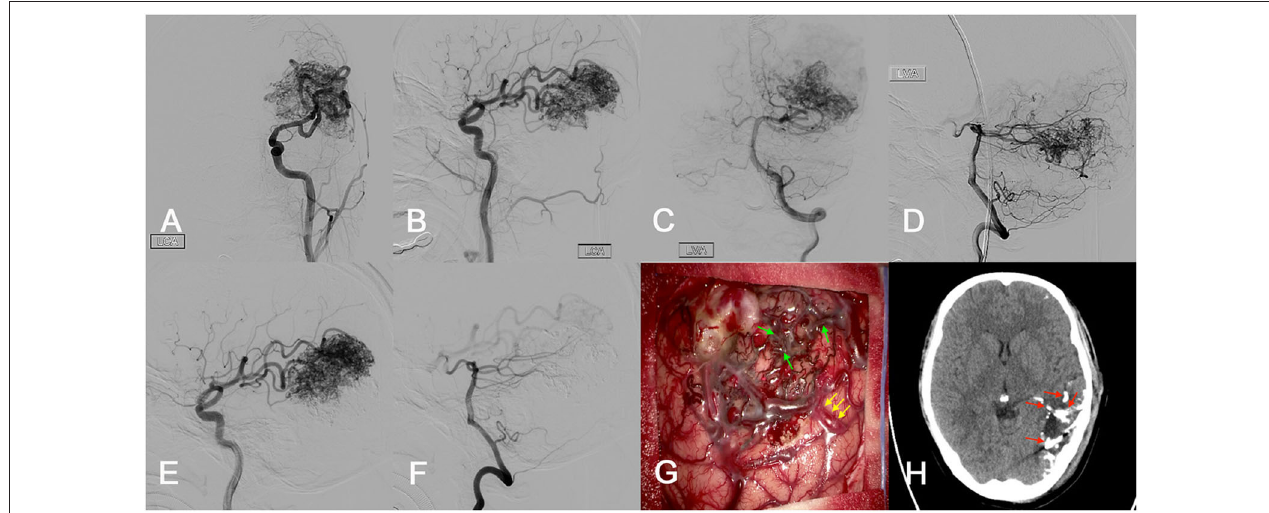
FIGURE 2 | Illustration case. A 25-year-old female presented with loss of consciousness accompanied by physical convulsions 10 days before admission. (A–D) The preoperative imaging examination suggested an unruptured AVM in the left parietal occipital lobe (SM grade IV). The maximum diameter was 7.1cm. The nidus was supplied by the ipsilateral middle cerebral artery (MCA) and posterior cerebral artery (PCA). The nidus was compact. She received a single-stage combined embolization and resection 4 days after admission. (E,F) The intraoperative embolization was mainly performed on the nidus supplied by the ipsilateral PCA, and the overall embolization degree was Grade B (30–60%). (G) After craniotomy, the main feeding artery was controlled and blocked with aneurysm clips (main feeding artery: yellow arrow). The embolized vessels and lesions appear black (embolized lesions: green arrow), which make the lesion boundary easy to be identified. (H) Intraoperative DSA and postoperative CT showed completely obliteration of the lesion. In order to preserve important neurological functions, a small number of embolized lesions adjacent to the eloquent area were maintained during resection (maintained embolized lesion: red arrow). Immediate DSA after the microsurgical resection procedure demonstrated complete obliteration of the lesion. The intraoperative blood loss was 200ml and the resection duration was 2.9h. After 2.4 years’ follow-up, she experienced no neurofunctional deficit and mRS score of